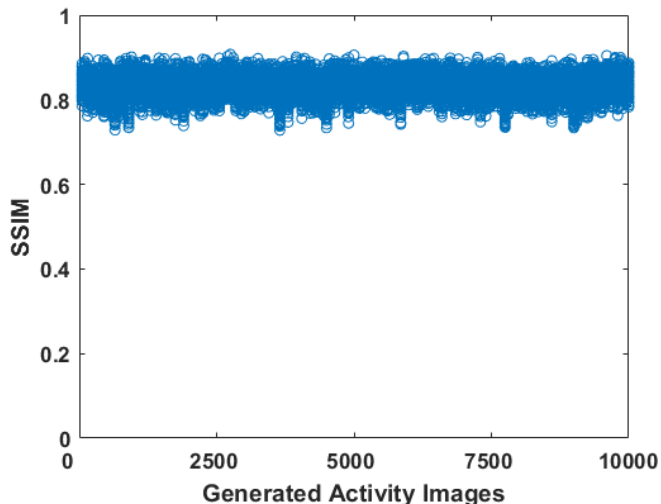
Figure 6. The SSIM values. The transverse axis represents the 10,000 generated phantoms. The vertical axis represents the SSIM values when comparing training phantoms with each generated phantom.